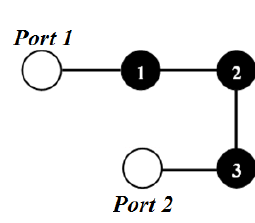
FIGURE 5. Step one: EM response of tuned results (solid lines) and target results (dashed lines).